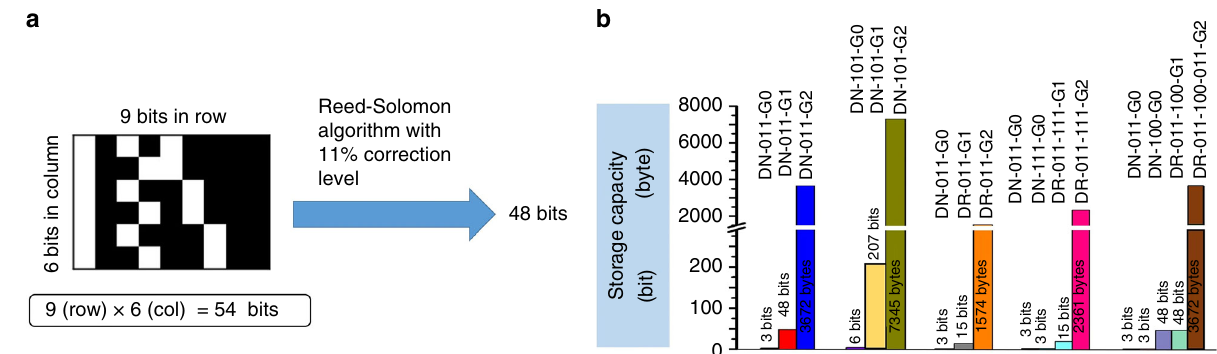
Fig. 5 Storage capacity of the digital dendrimers. a Calculation of the storage capacity of digital dendrimer DN-011-G1 via corresponding data matrix barcode with correction level of 11%. b Summary of the storage capacities of the digital